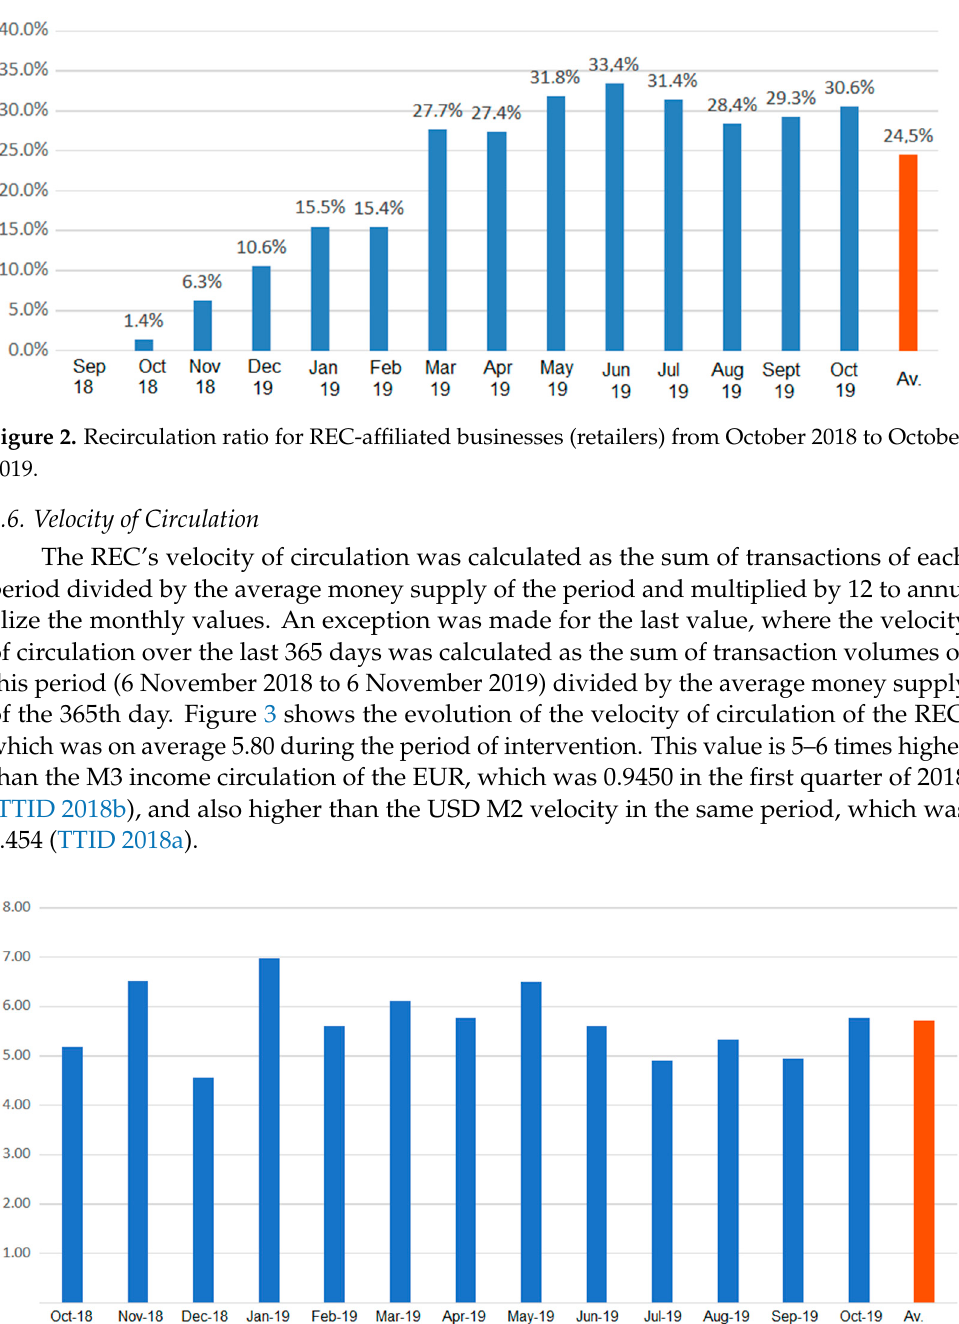
Figure 3. Annualized velocity of REC local currency from October 2018 to October 2019.